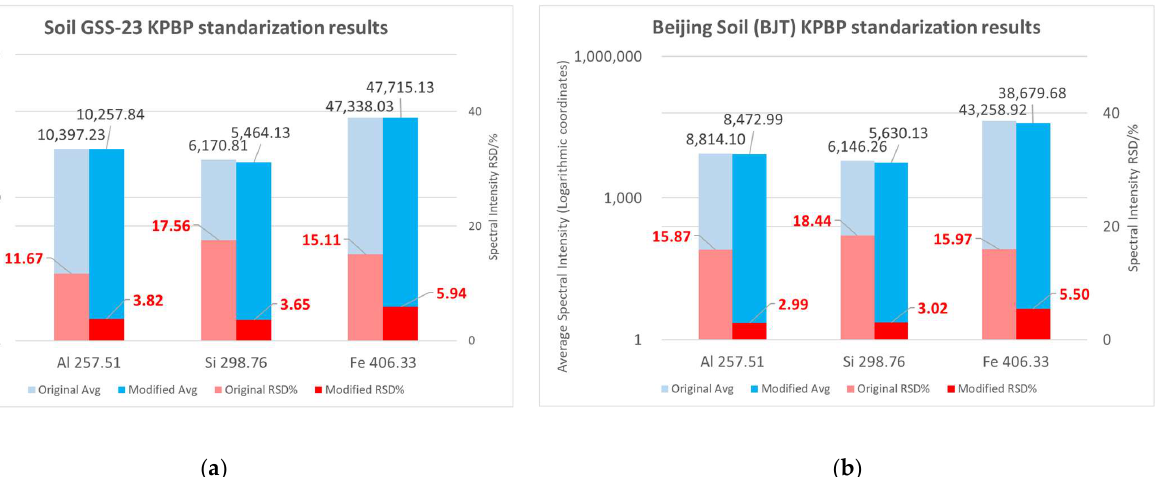
Figure 13. The KPBP standardization results for different soil samples. ( a ) GSS-23 standard soil sam- ple. ( b ) BJT, a farmland soil sample collected from the suburbs of Beijing. sample. ( b ) BJT, a farmland soil sample collected from the suburbs of